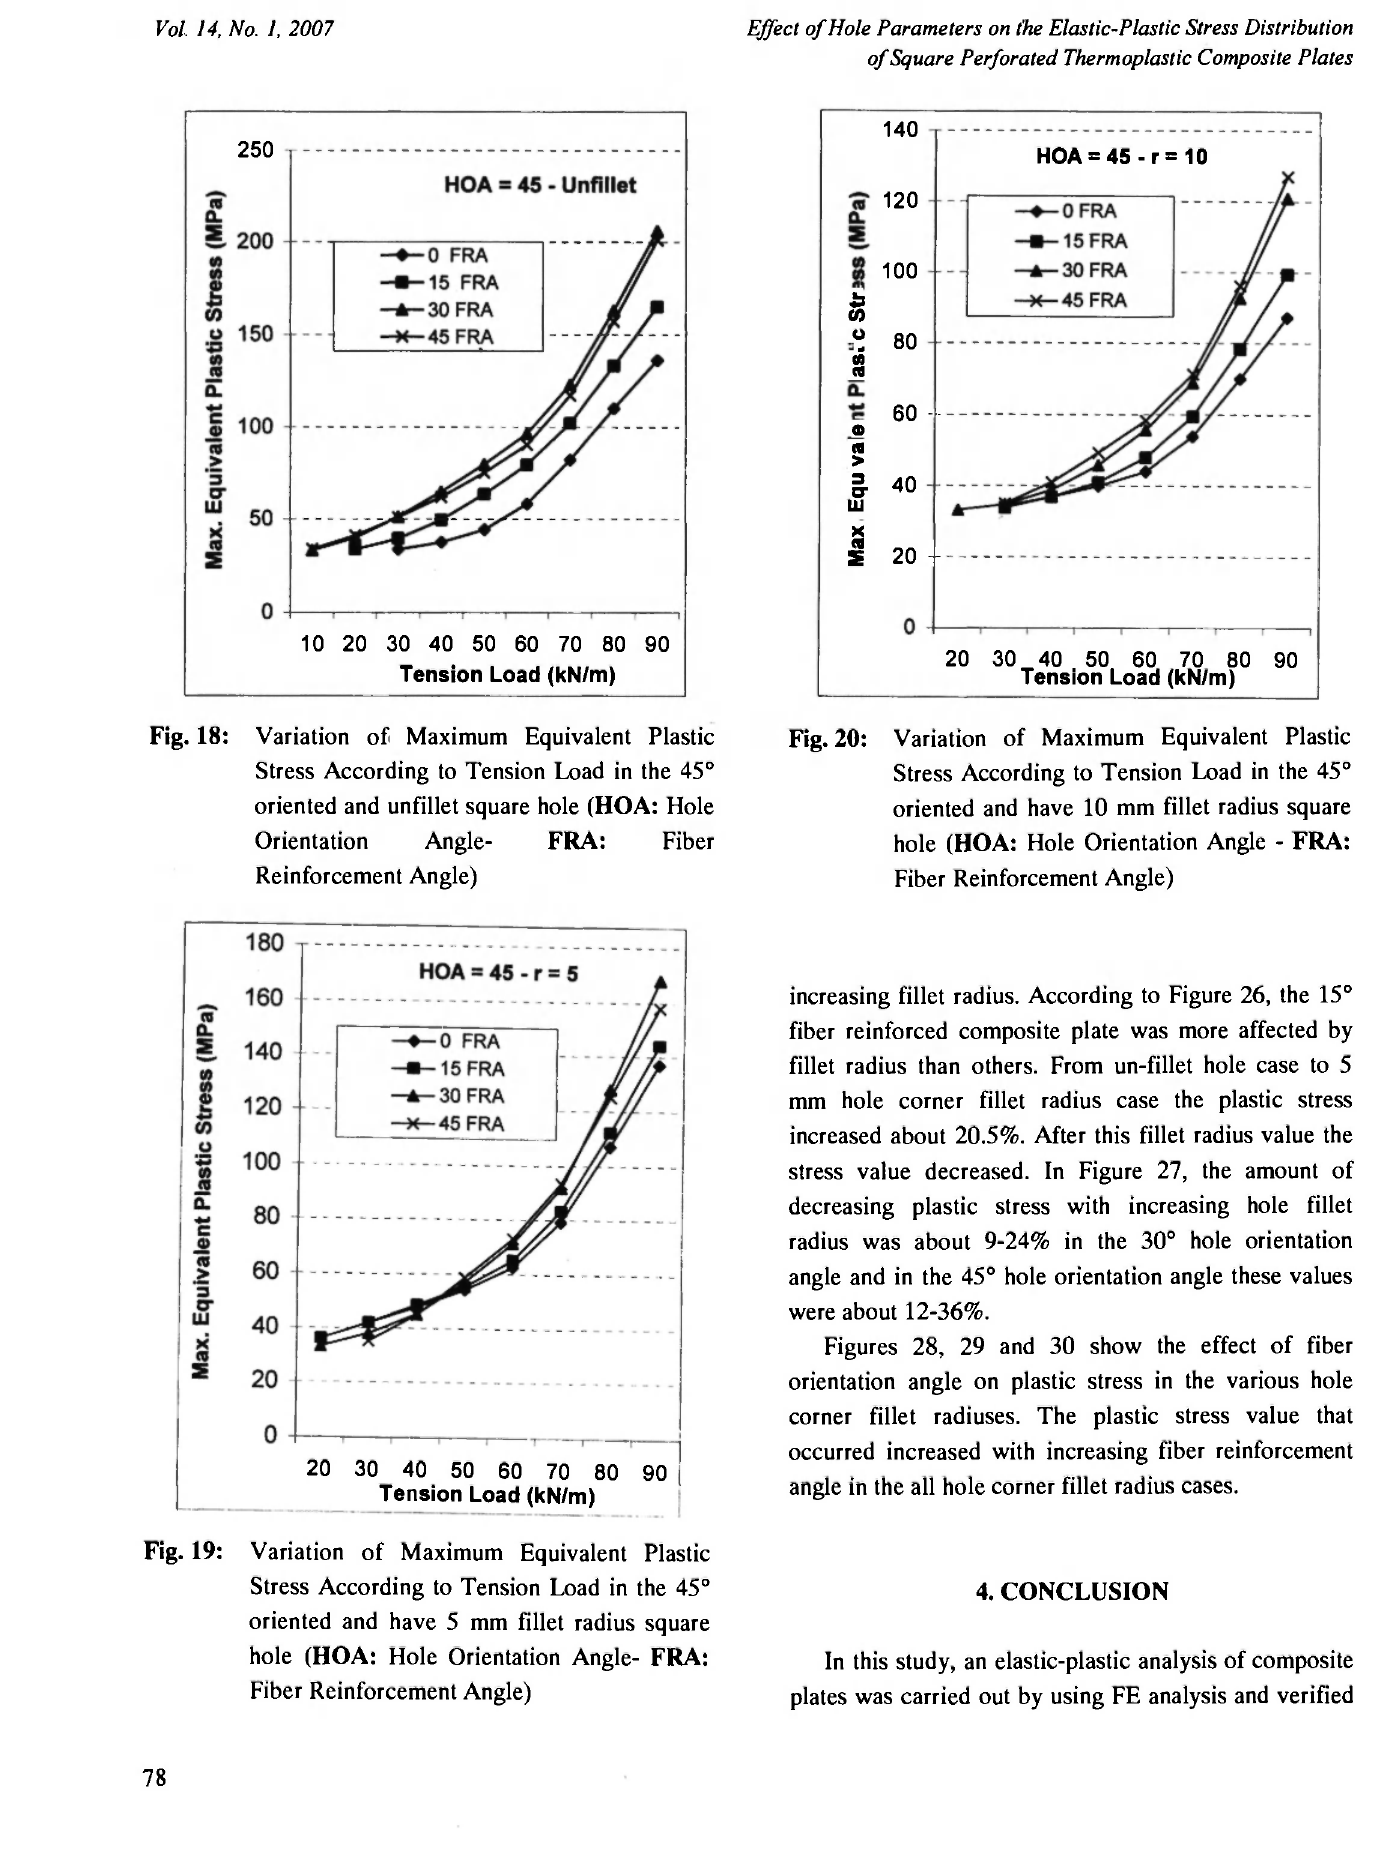
Fig. 18: Variation of Maximum Equivalent Plastic Stress According to Tension Load in the 45° oriented and unfillet square hole (HOA: Hole Orientation Angle-